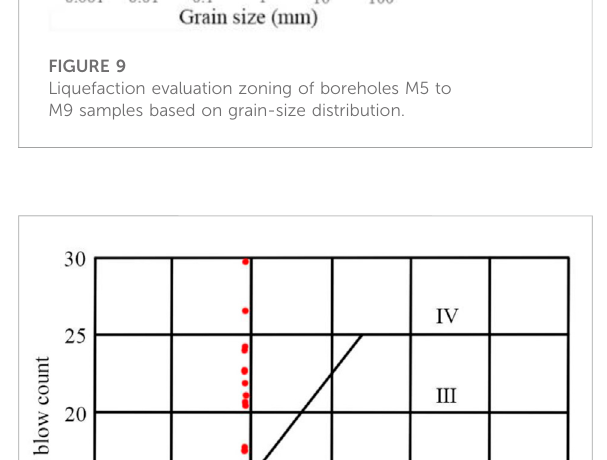
FIGURE 9 Liquefaction evaluation zoning of boreholes M5 to M9 samples based on grain-size distribution.